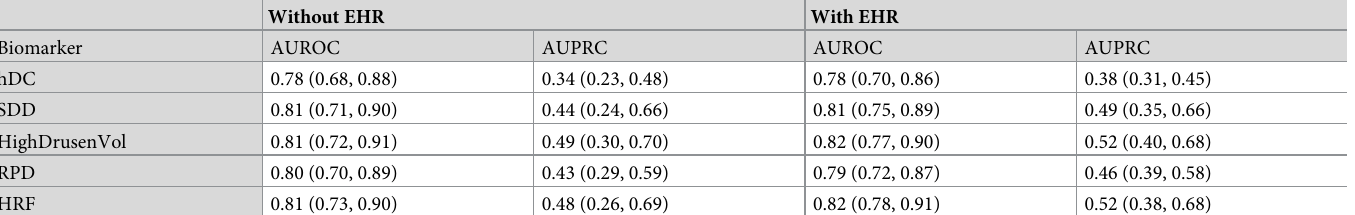
Table 2. Performance metric comparison of models built upon the trivial feature set and a single biomarker (Without EHR), and the EHR baseline feature set and a single biomarker (With EHR). Without EHR With EHR